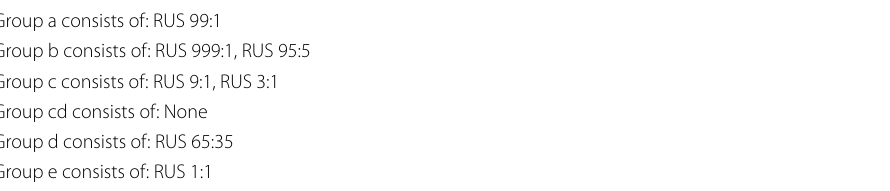
Table 19 HSD groupings of sampling ratios after 2-factor ANOVA where classifier and sampling ratio are factors; groups are by performance in terms of